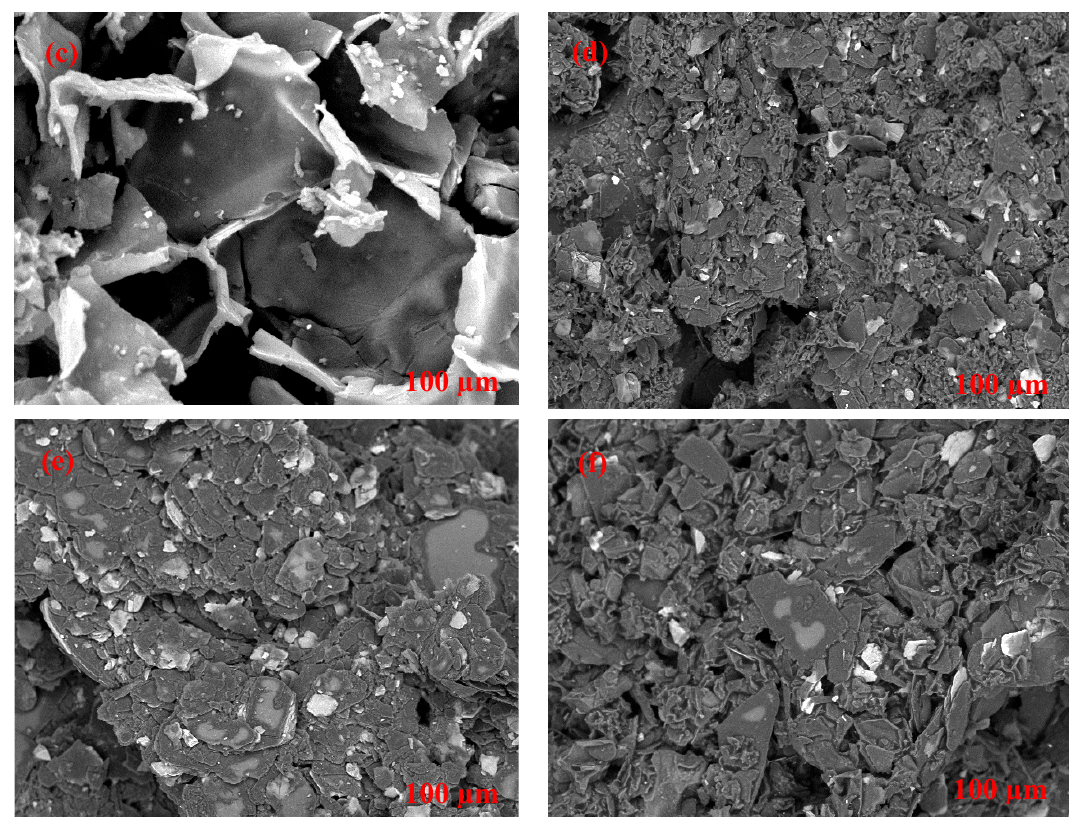
Figure 1. SEM micrographs of ( a ) raw cork (RAC), ( b ) RAC after washing, ( c ) regranulated cork (RGC, ( d ) graphite (Gr), ( e ) GrRAC, and ( f ) GrRGC, using a magnification of 1500×.